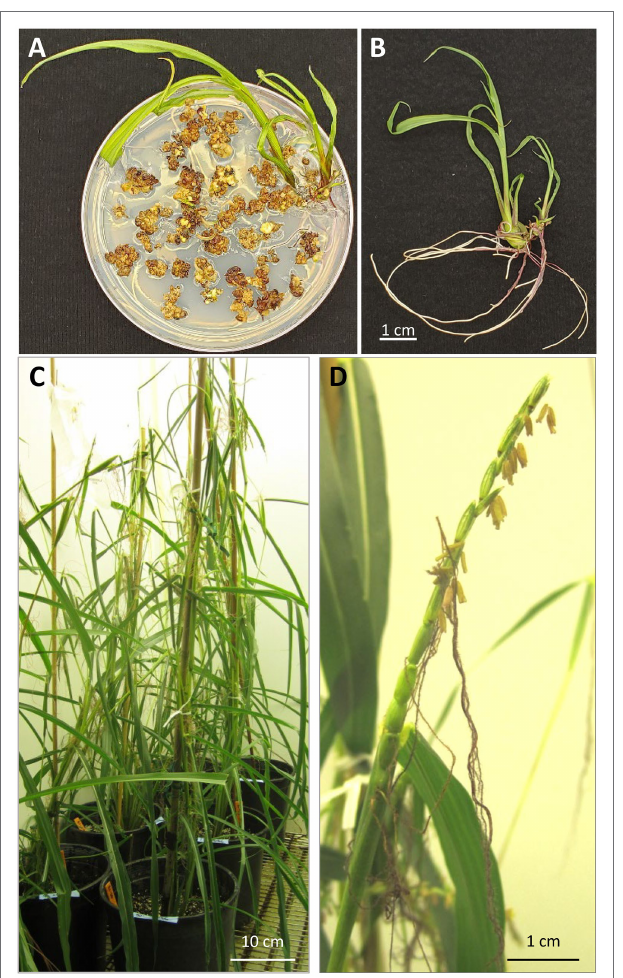
FIGURE 6 | Molecular analysis of transgenic teosinte plants. (A) PCR results from genomic DNA extracted from pKL2155 transgenic T0 leaf tissue. Bands of 696 bp indicate the tdTomato red fluorescent marker gene is present in the genomic DNA samples; MW, 1 Kb Plus DNA ladder; wt, wild-type non- transgenic teosinte; lanes 1–7, seven genomic DNA samples representing five independent pKL2155 events; pos, pKL2155 plasmid; neg, no DNA negative control; (B) Southern blot analysis of six T0 and two T1 transgenic plants derived from one pAHC25 event. Fifteen micrograms of genomic DNA were digested with Sac I restriction enzyme, which cuts only once in the plasmid pAHC25. The membrane was hybridized with a 421 bp, 32 P-labeld gus probe. MW, 2-Log DNA Ladder; wt, wild-type teosinte; pos, wild-type teosinte genomic DNA spiked with pACH25